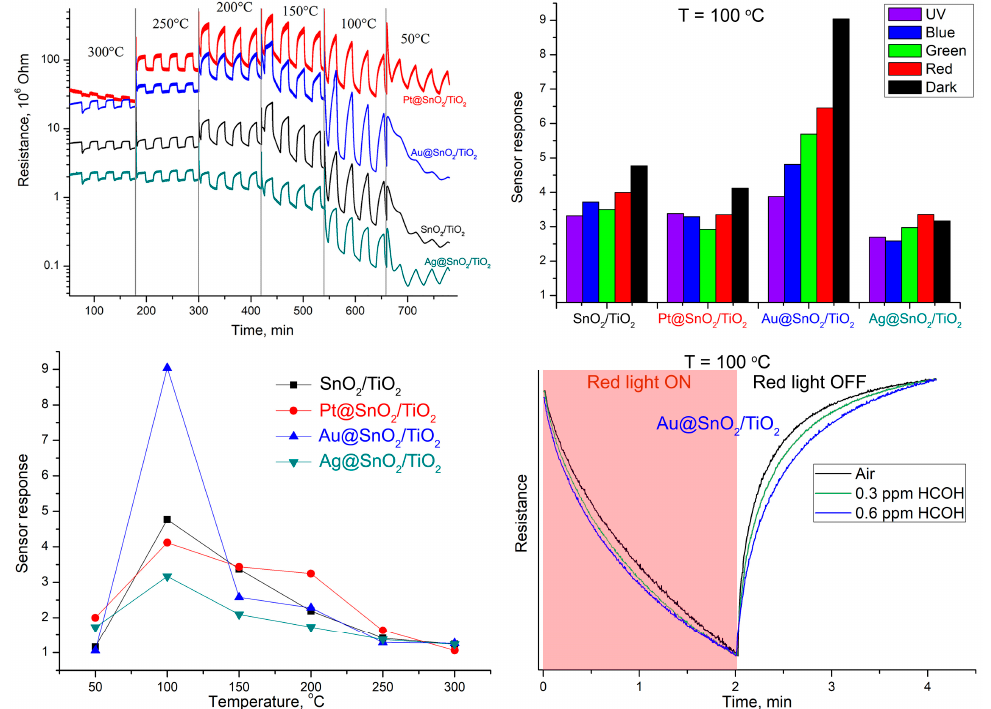
Figure 1. ( a ) Change in the samples resistance at periodic changing the composition of the gas phase; ( b ) Temperature dependences of sensor response to 0.6 ppm HCOH in dark conditions; ( c ) Influence of constant illumination on sensor response to 0.6 ppm HCOH at 100 °C; ( d ) Change in the resistance of Au@SnO 2 /TiO 2 nanocomposites at 100 °C during one “Light ON/OFF” cycle in dry air containing 0, 0.3 or 0.6 ppm